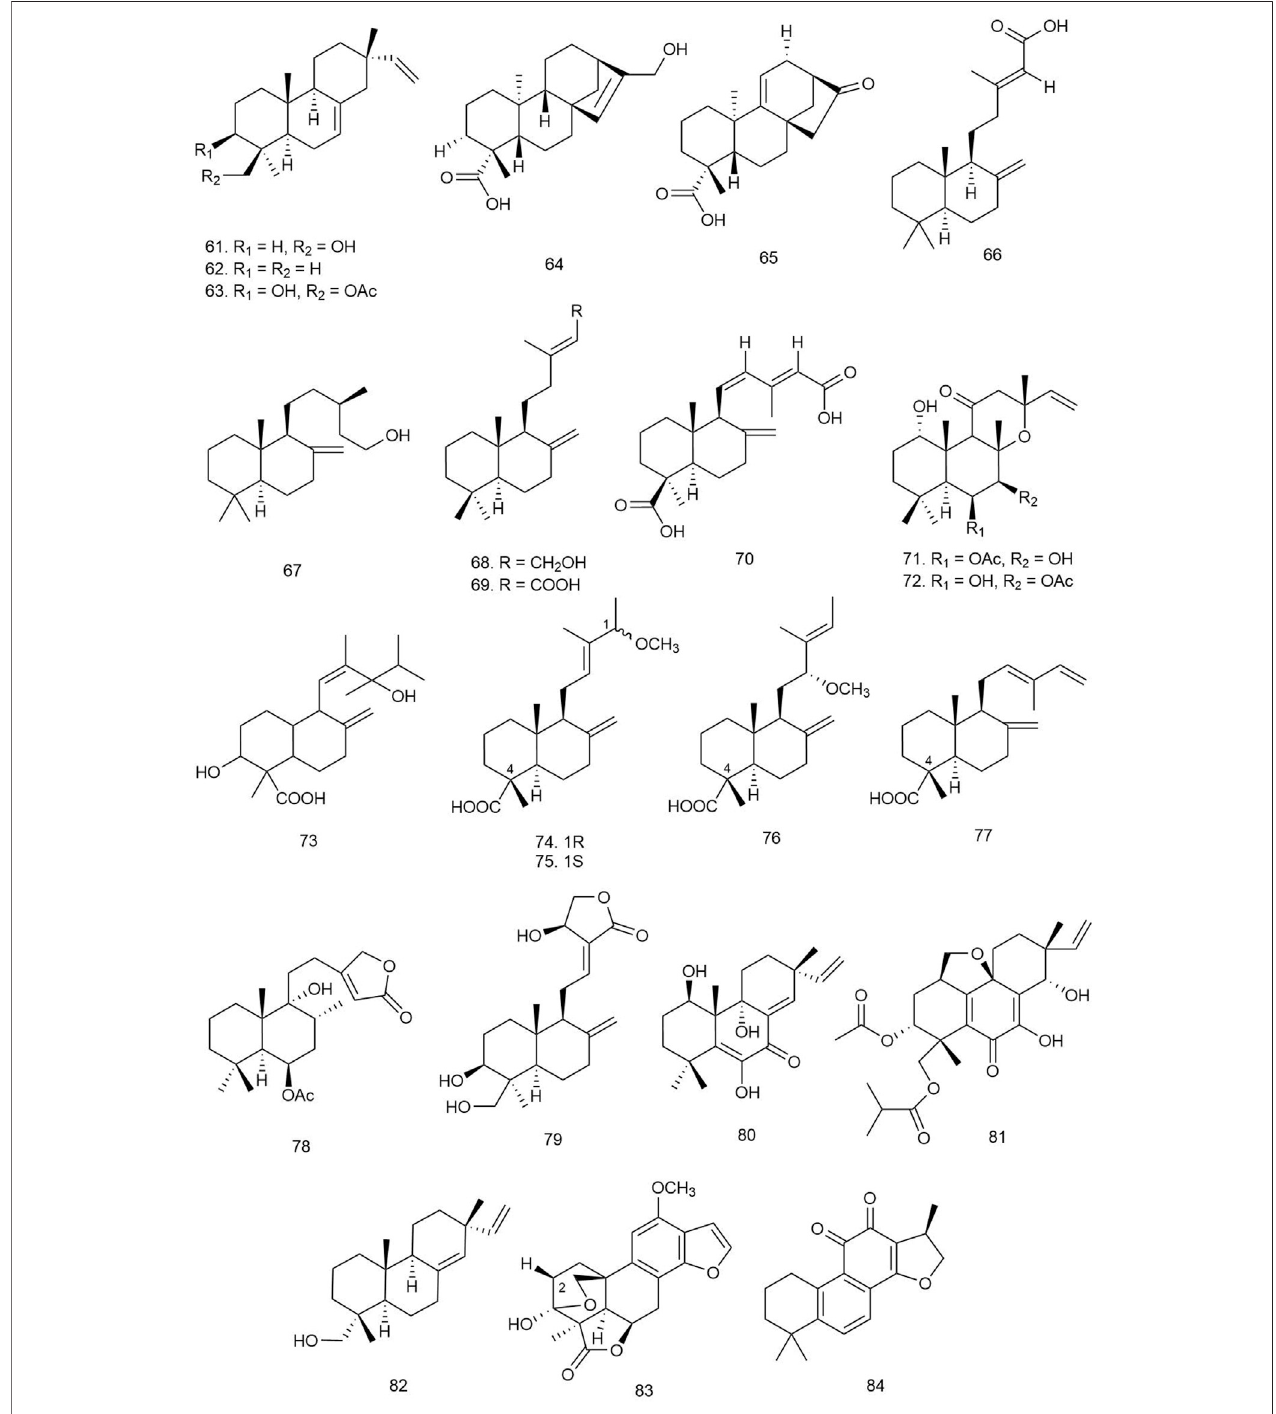
FIGURE 5 | Structures of isopimarane, kaurene, labdane, lactone, pimarane, and quinone diterpenoids with signi fi cant antibacterial activity.